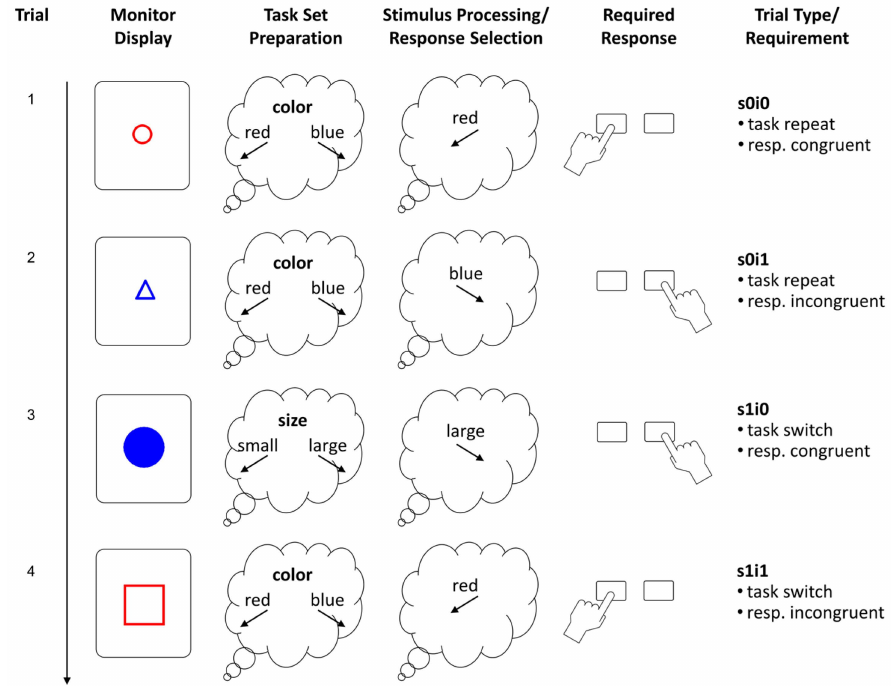
Figure 1. Schematic of the task-switching paradigm. The leftmost column shows the monitor display, the next columns illustrate the task-set preparation and stimulus processing requirements as well as the required response. The rightmost column presents the trial type as defined by task sequence and response–congruency of the task-relevant and irrelevant stimulus attributes (i.e., size vs. color). The trial code specifies the processing requirements, whether the trial necessitates a task switch (s1) or not (s0), and whether the response–relevant and irrelevant stimulus attributes are associated with incongruent responses (i1) or not (i0). Trial 1 would be a task-repeat trial if the preceding warm-up trial (not shown here) was a color classification trial, too. Trial types were balanced but their pseudo-random sequence was unpredictable for